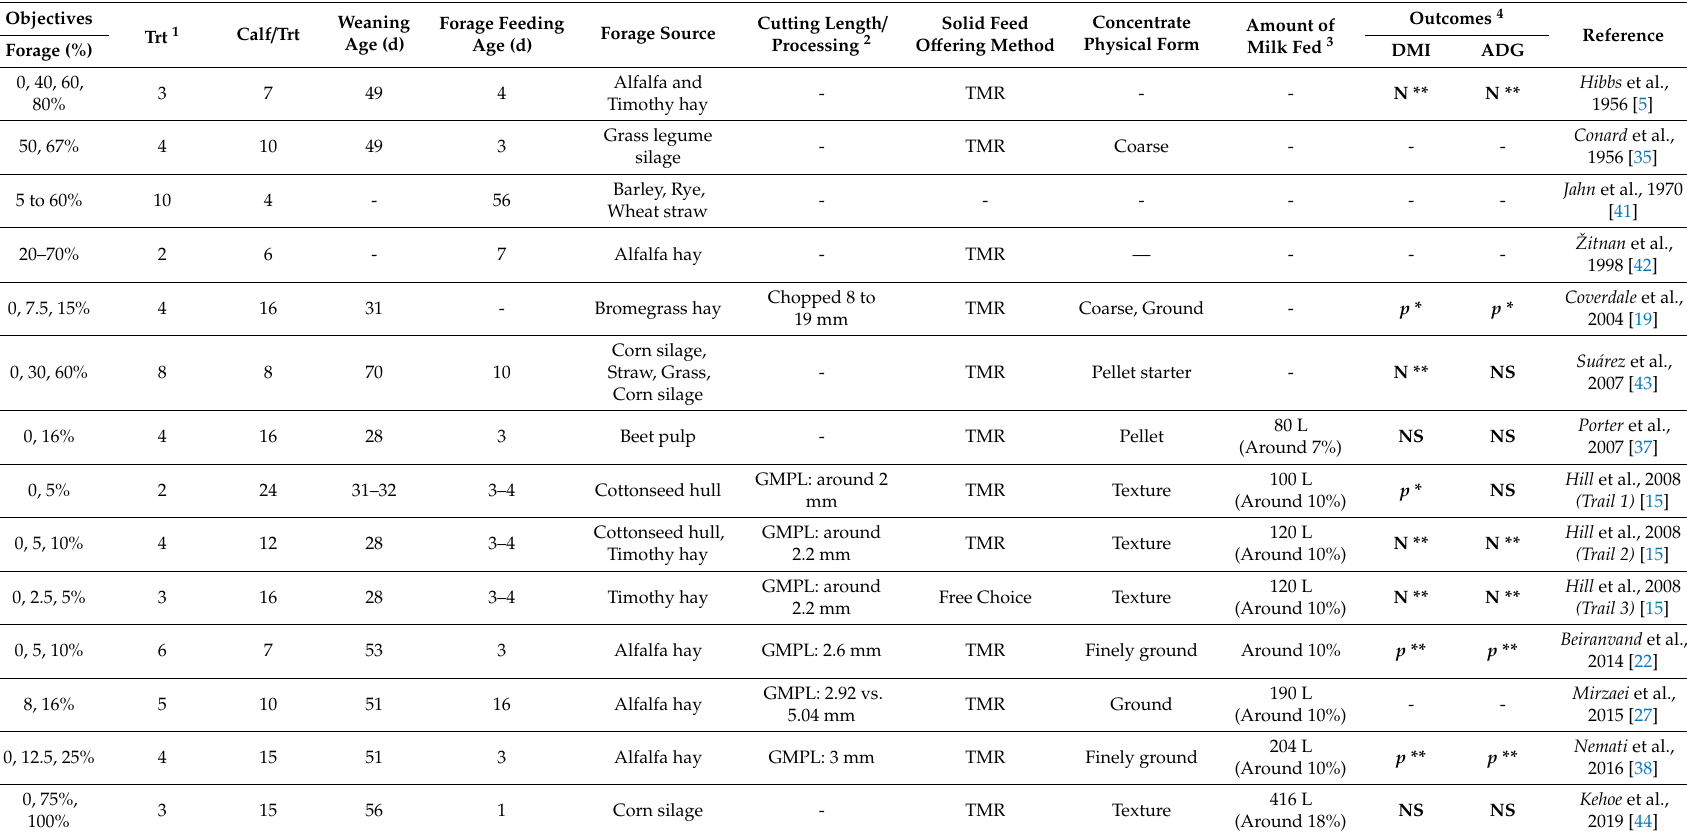
1 Trt = Treatment. 2 Geometric mean particle length (GMPL) refers to geometric mean particle length, which was determined using American Society of Agricultural and Biological Engineers (ASABE) forage sieve methods (ANSI / ASAE S424.1) [45]. 3 Amount of milk fed is the total amount fed during the whole trial period, while milk feeding rate equals the average daily milk allowance / birth body weight (%). 4 Outcomes = e ff ect of forage inclusion, ** indicates a significant e ff ect ( p < 0.05), * indicates a tendency ( p < 0.1), N indicates a negative e ff ect, p indicates positive e ff ect, and NS shows no significant e ff ect. DMI and ADG were evaluated by comparing calves fed with or without